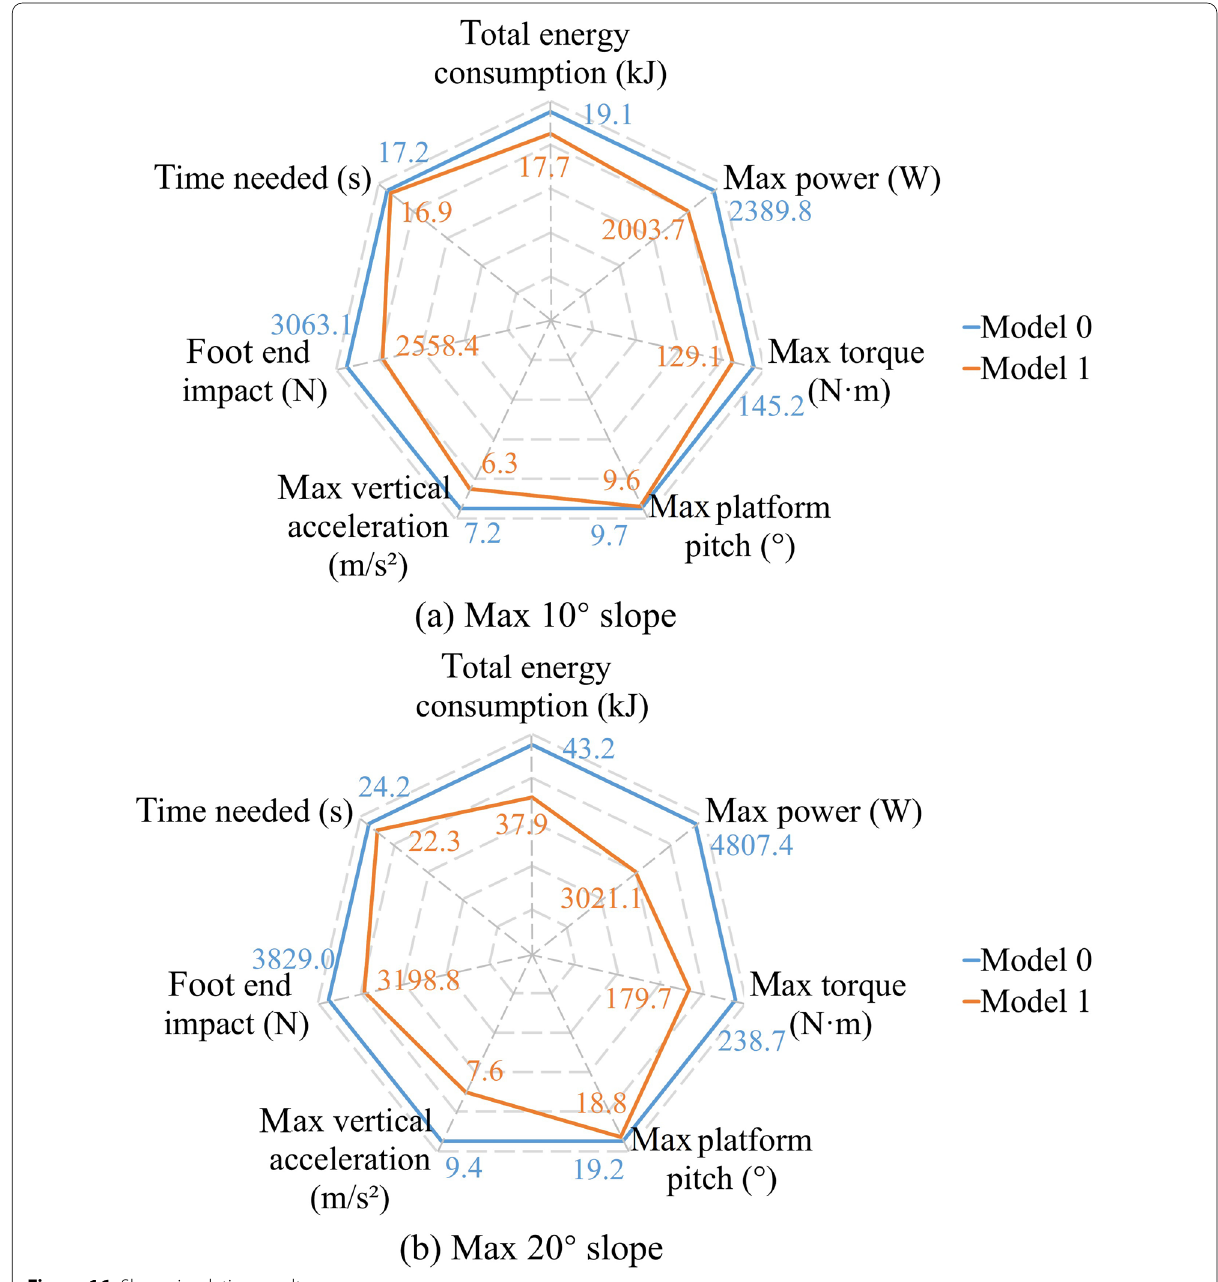
Figure 16 Slope simulation